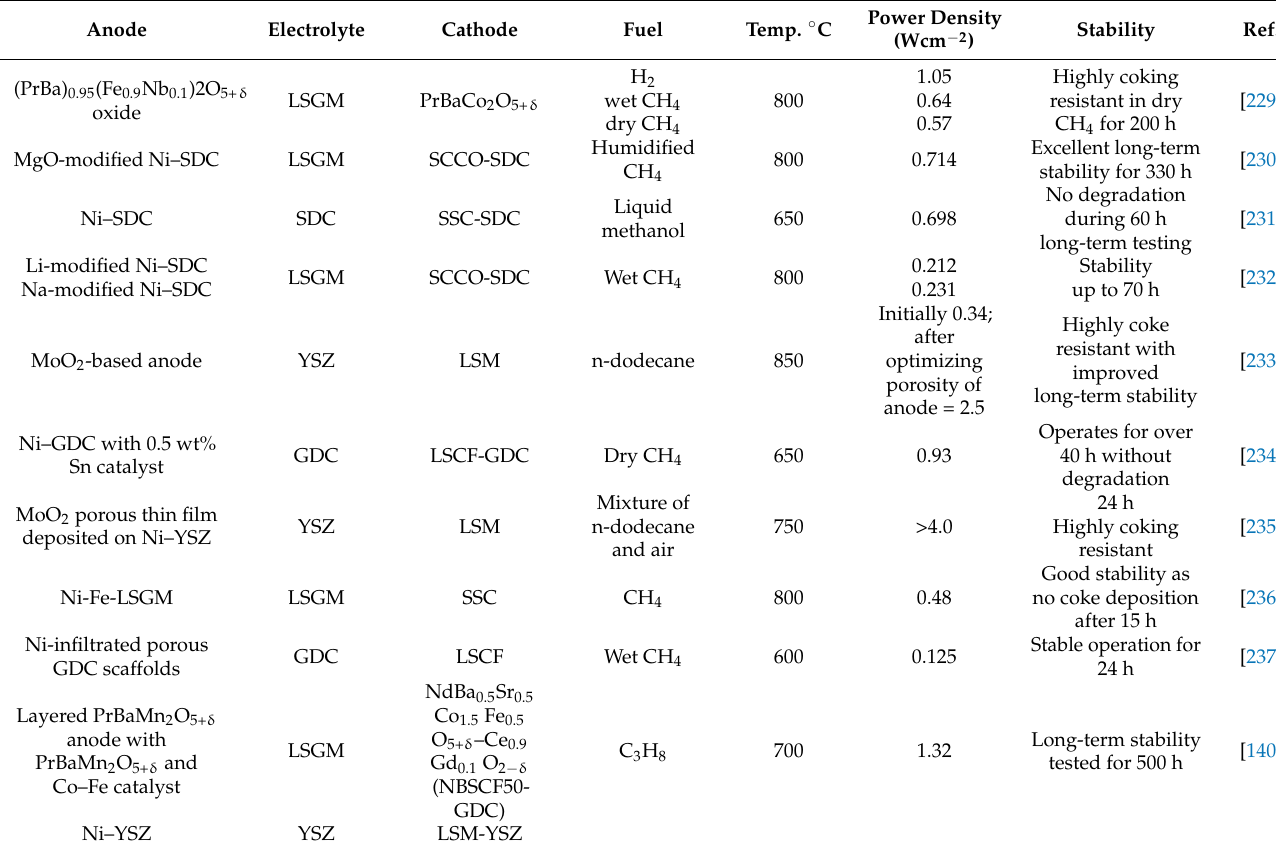
Table 2. Long-term stability data of SOFCs with hydrocarbon compatible